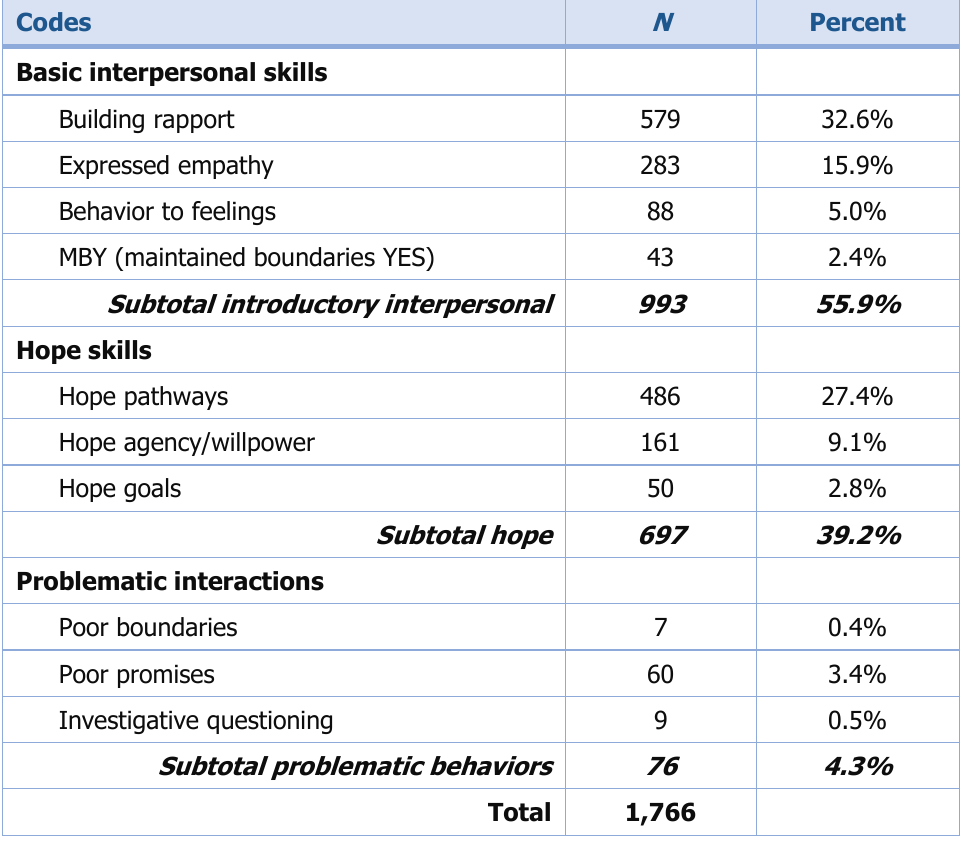
Table 3. Totals and Percentages of Simulation Coding of Camp Counselor